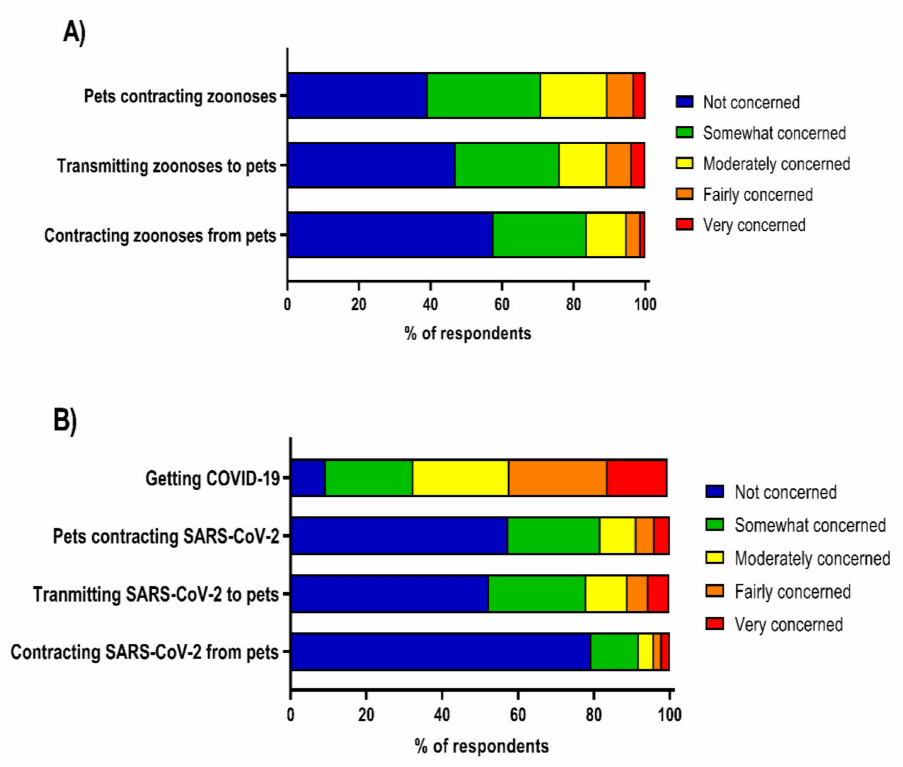
Figure 1. ( A ) Respondent concern about transmission of zoonotic diseases; and ( B ) respondent concern about COVID-19 and zoonotic transmission of